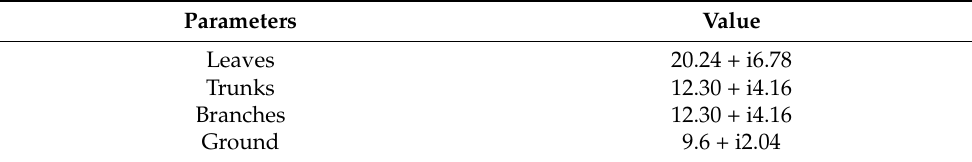
Table 3. The dielectric parameters of scatterers.